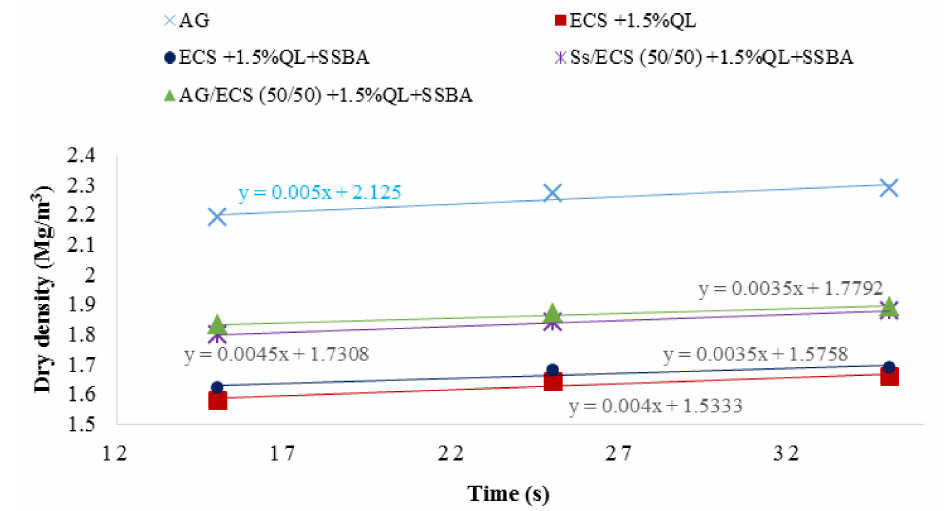
Figure 7. Dry density–compaction time